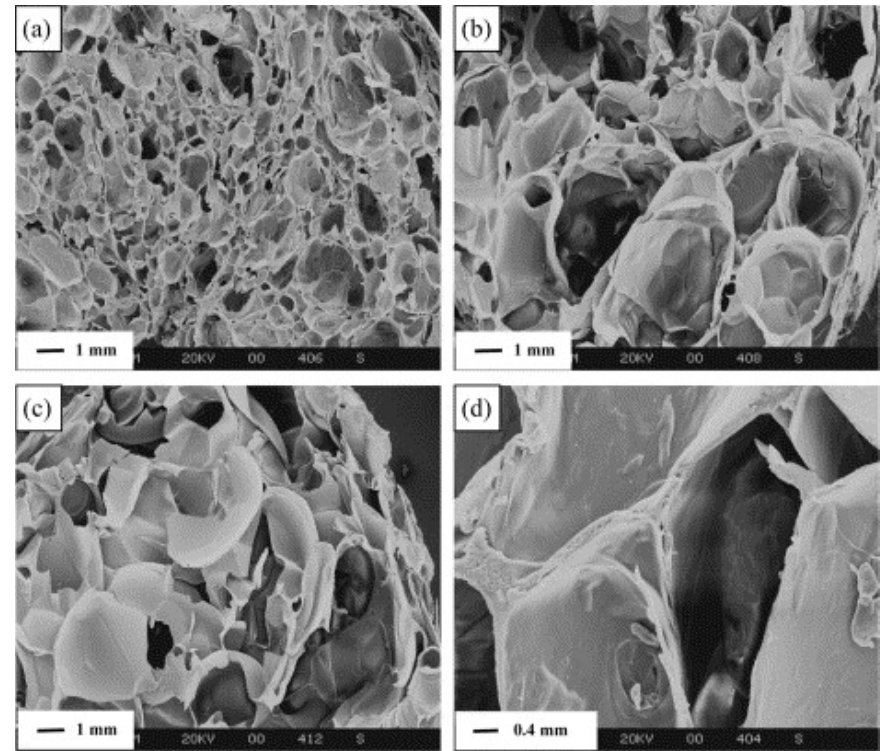
Figure 9. ( a ) Scanning electron micrographs of foamed temple pellets with various additives: ( a ) Temple; ( b ) Temple/BIH (1.5% w / w ); ( c ) Temple/talc (0.8% w / w ); ( d ) Temple/talc (2.2% w / w ). Reprinted with permission from [48]. Copyright © (2006) Elsevier.